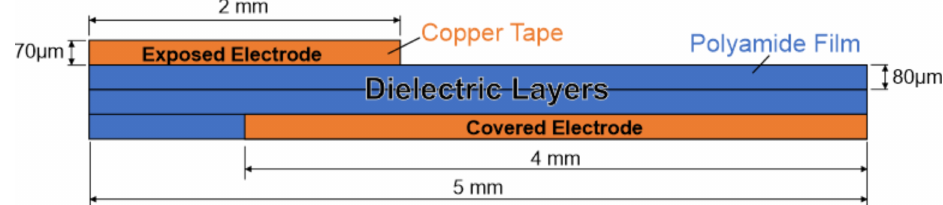
Figure 5. Single DBD plasma actuator